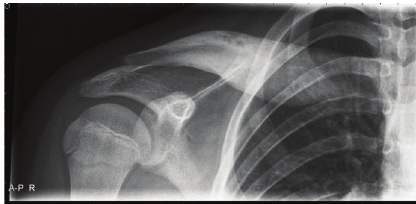
Figure 7: Ossification of the